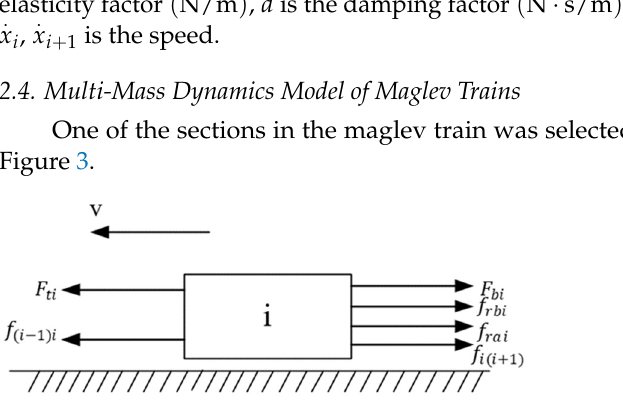
Figure 3. Force diagram of a single maglev train carriage.